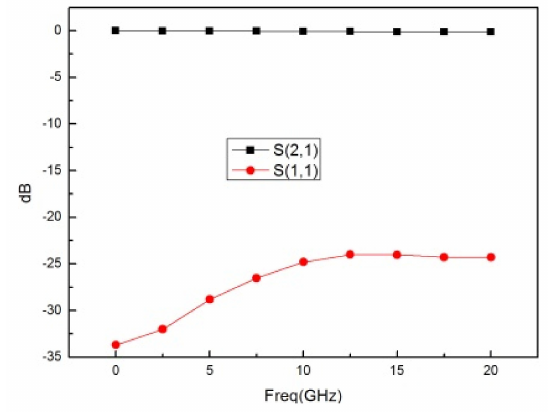
Figure 7. Coaxial-like microstrip simulation